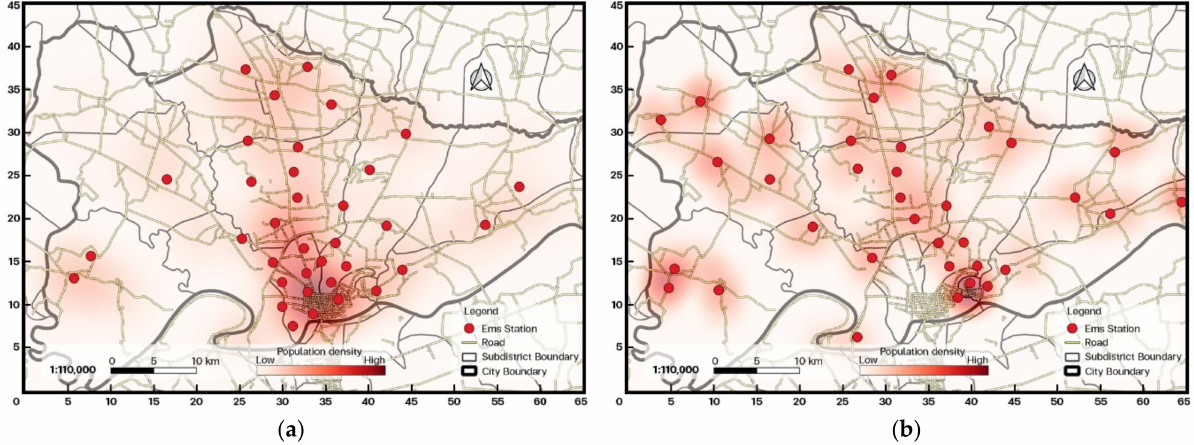
Figure 10. Day and night EMS